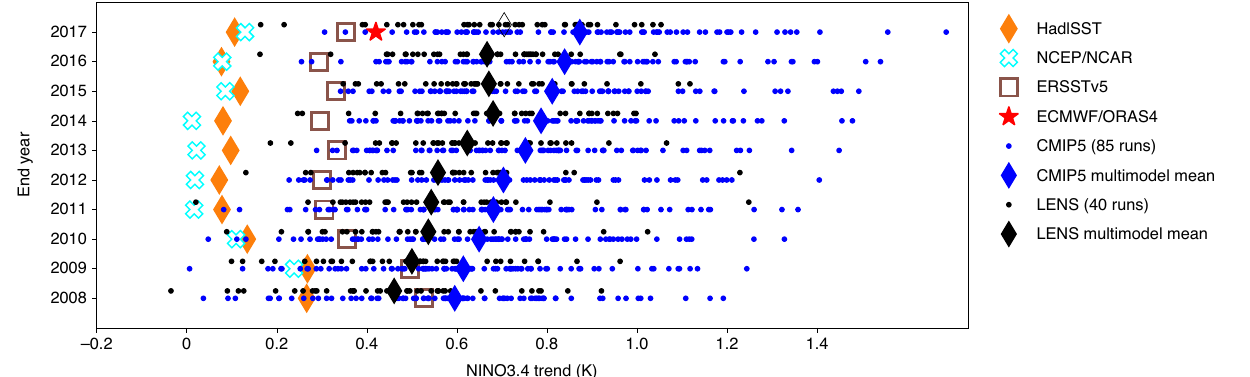
Fig. 3 A comparison of observed and modeled SST trends in the Niño-3.4 region. The fi gure shows the distribution of 60-year trends in the Niño-3.4 region (5°S-5°N and 170°W-120°W) for end dates ranging from 2008 – 2017 for 88 individual CMIP5 model runs and 40 NCAR LENS runs. The CMIP5 and LENS multimodel means for each 60-year trend are also shown as blue and black diamonds. Also shown are the observational estimates from ECMWF, HadISST, National Centers for Environmental Prediction (NCEP)/NCAR and ERSSTv5 SST analyses. (Adapted from ref. 27 ).